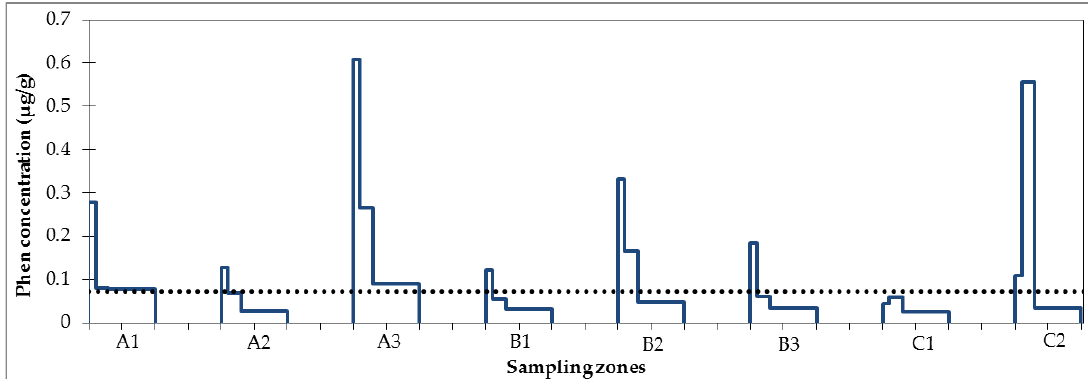
Figure A4. Concentrations of zinc measured in composite cores of each sampling zone. Within each zone, concentrations from cores taken at depths of 0–5 cm, 5–15 cm and 15–50 cm are represented to scale from left to right. The dotted line represents the concentration measured in the initial soil sample.